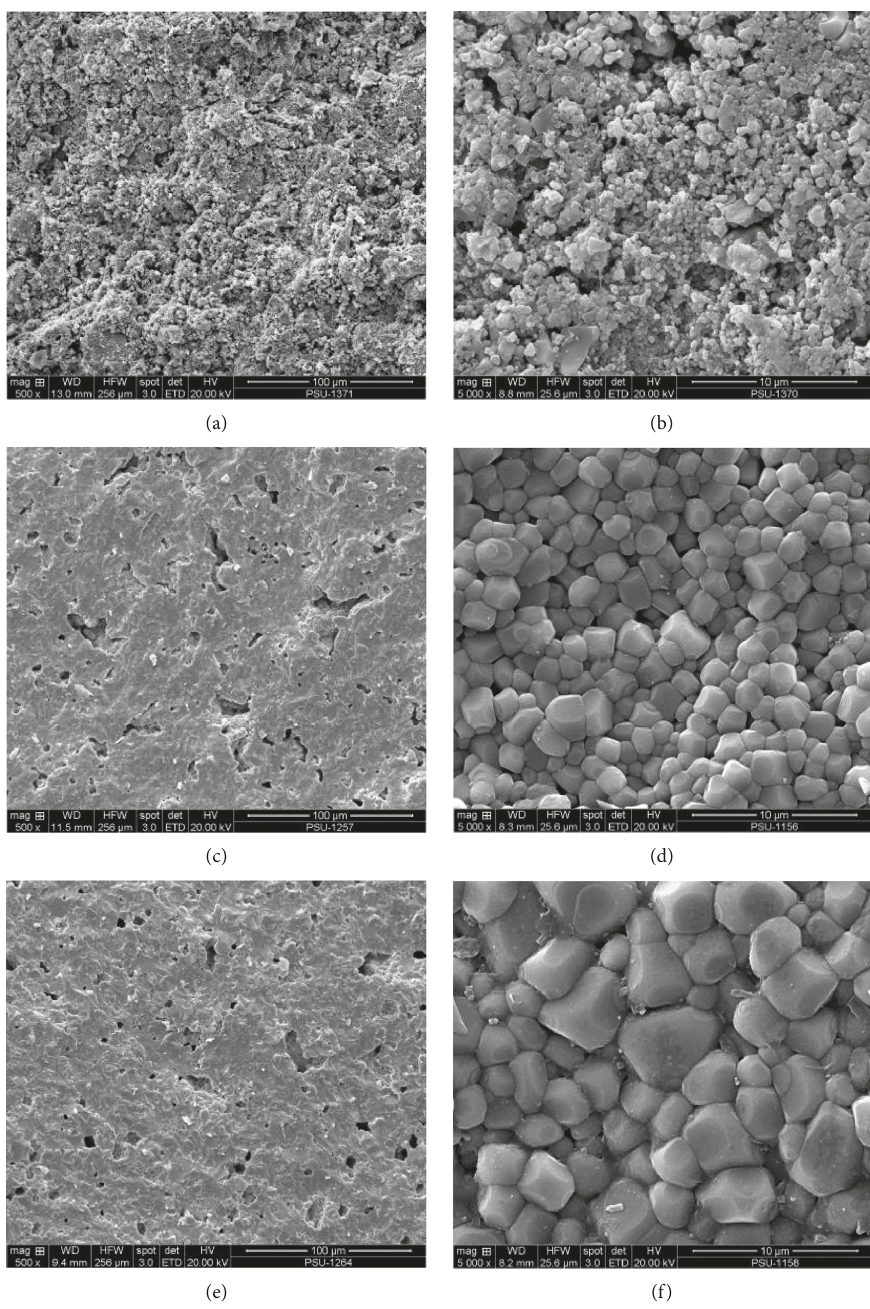
Figure 12: SEM images of the microstructure of calcium titanate ceramics sintered at 1350 ° C in air represent fracture and top surface with different holding times (a, b) 60, (c, d) 120, and (e, f)